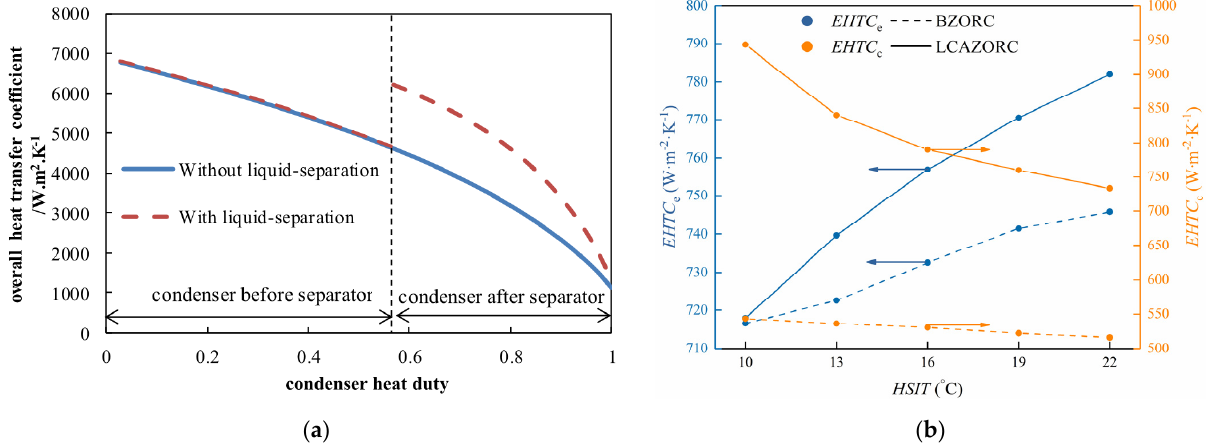
Figure 11. Heat transfer efficiency of plate-type LSC from: ( a ) Luo et al. [68] Reproduced with permission from Luo et al., Energy Conversion and Management; published by Elsevier, 2017; and ( b ) Lu et al. [69]. Reproduced with permission from Lu et al., Energy Conversion and Management; published by Elsevier, 2020.